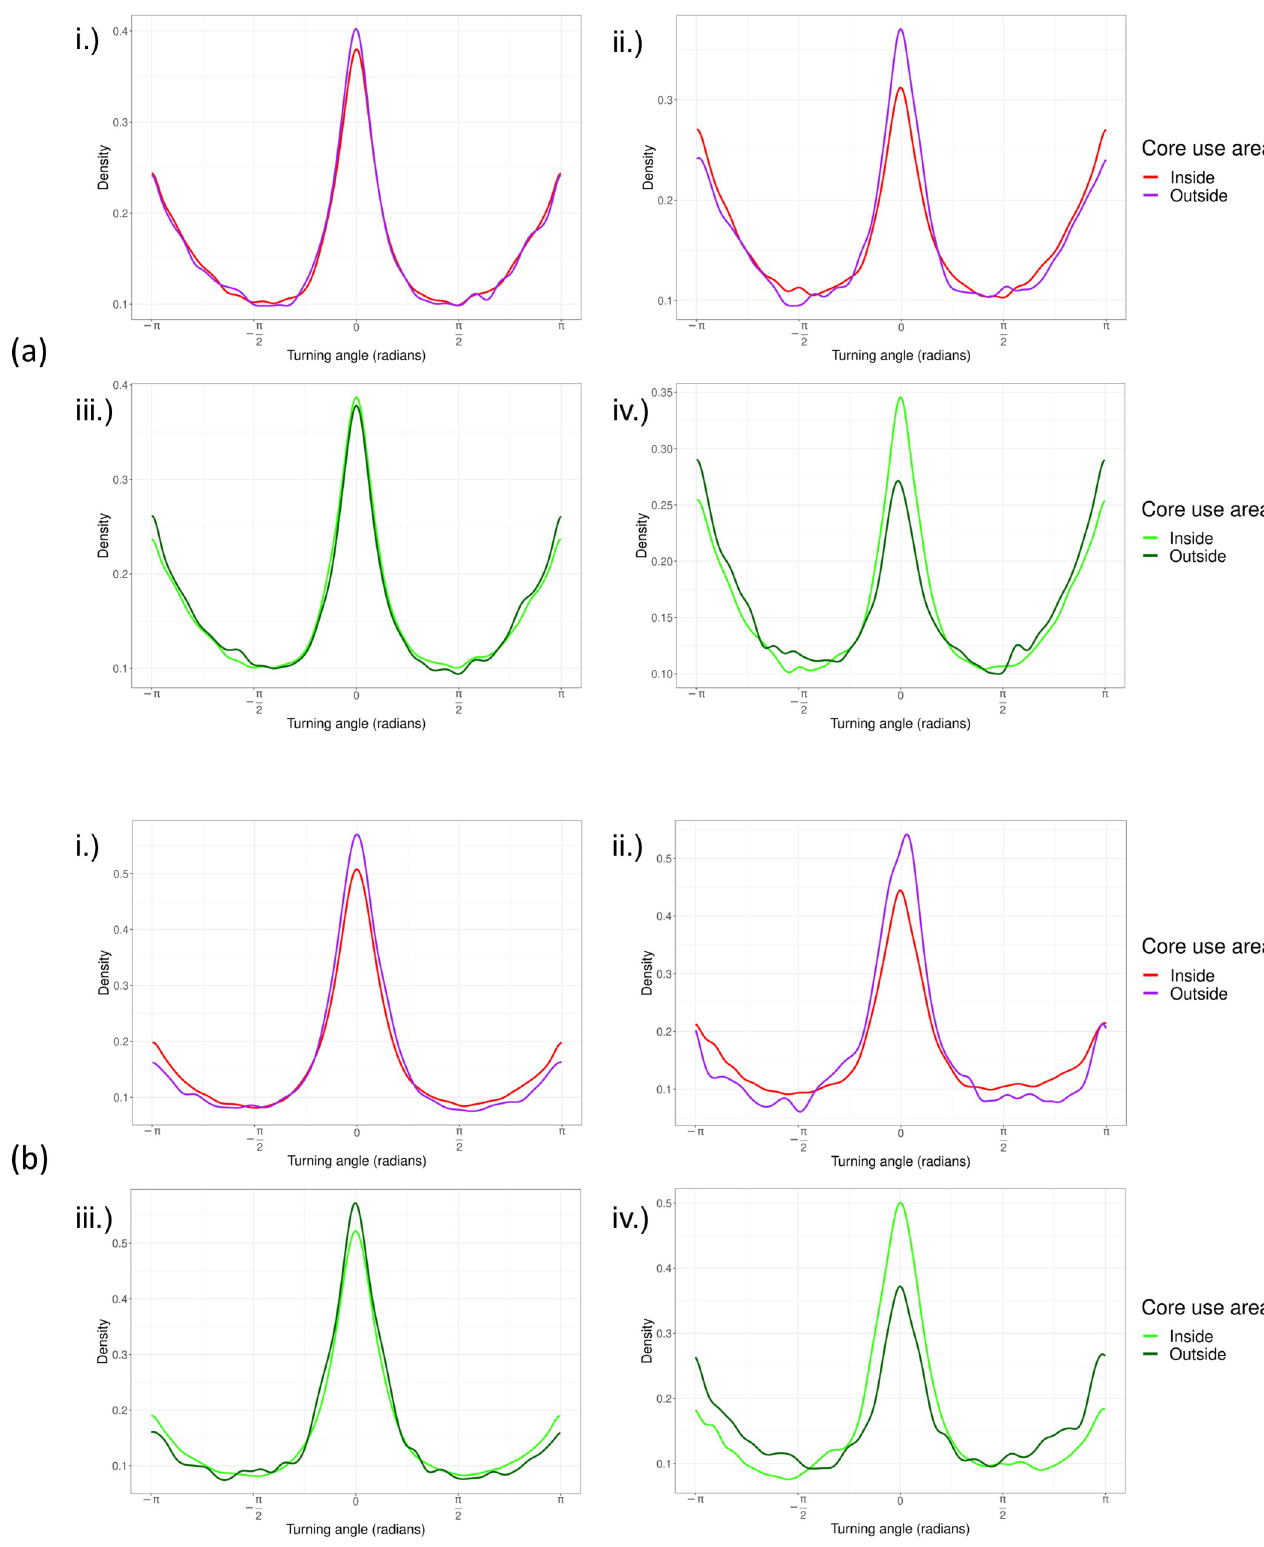
Fig 10. Tortuosity of lions and spotted hyenas with respect to competitor core use areas. Tortuosity of (a) lions and (b) spotted hyenas from the Etosha National Park, Namibia (i & iii) and the Chobe National Park and Linyanti Conservancy, Botswana (ii & iv). Path tortuosity is shown from inside and outside of competitor core areas (i & ii), and conspecific core areas (iii & iv). https://doi.org/10.1371/journal.pone.0265054.g010 PLOS ONE | https://doi.org/10.1371/journal.pone.0265054 February 3,